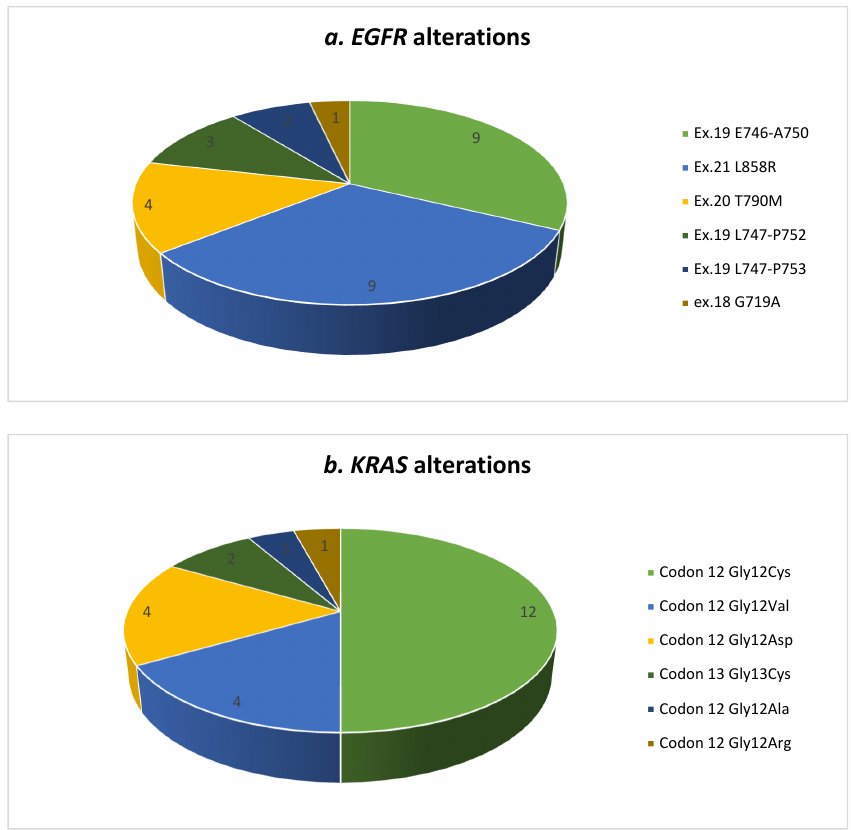
Figure 1. Graphical representation of the mutation type identified for both EGFR and KRAS. ( a ) EGFR alterations identified; ( b ) KRAS alterations identified. J. Clin. Med. 2019 , 8 , x FOR PEER REVIEW